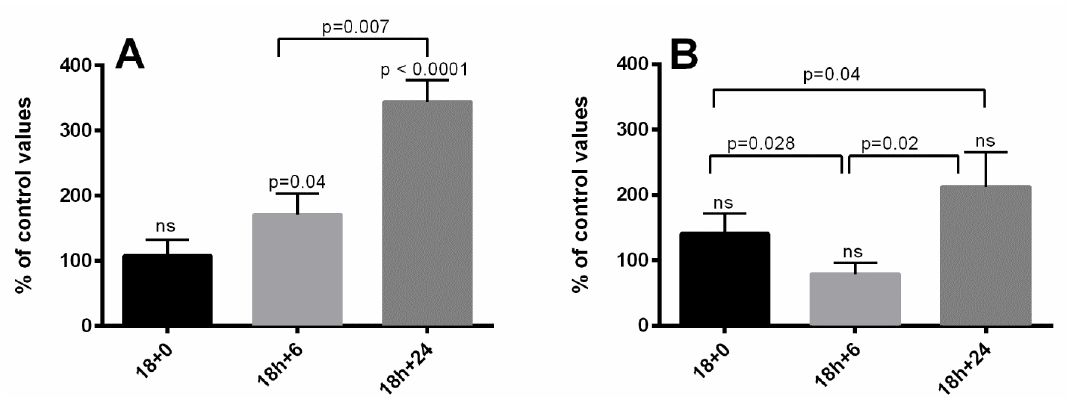
Figure 5. Evolution of Caspase-3 (17-19kDA) as percent variation from baseline in JURKAT ( A ) and CCRF-SB ( B ) cells after an 18-h hyperoxic exposure as compared to normoxia.